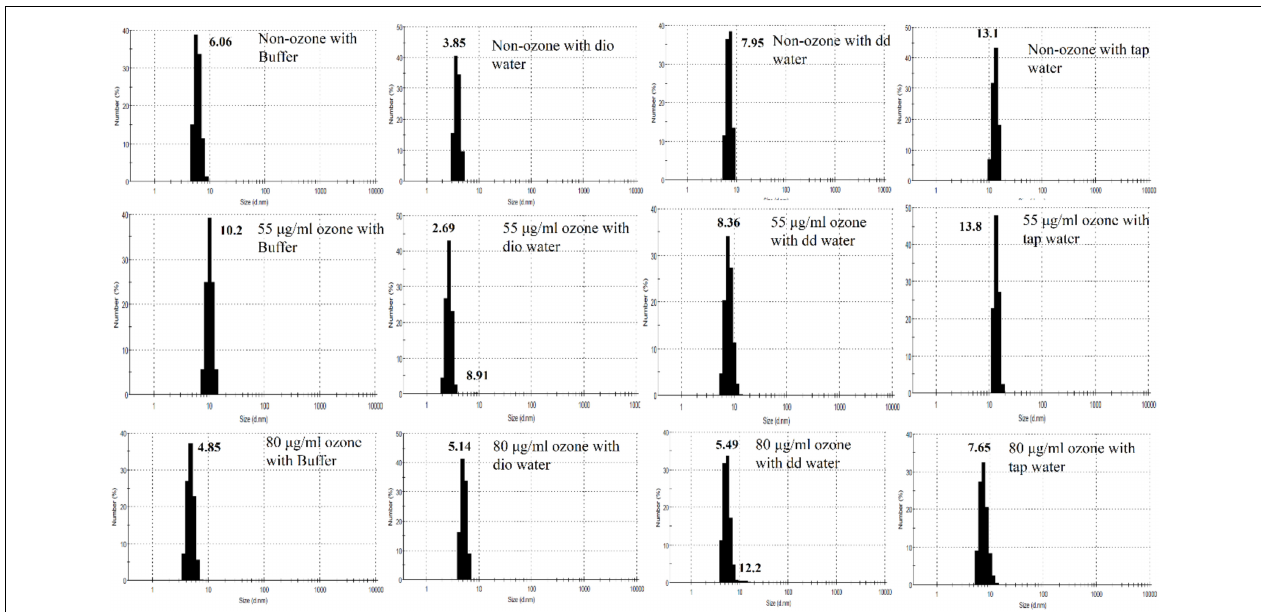
FIGURE 8 | Diameter size distribution of non-ozonated and ozonated Hb samples in the presence of phosphate buffer and diluted versions with different water types dio and dd water refer to deionized and double distilled water,